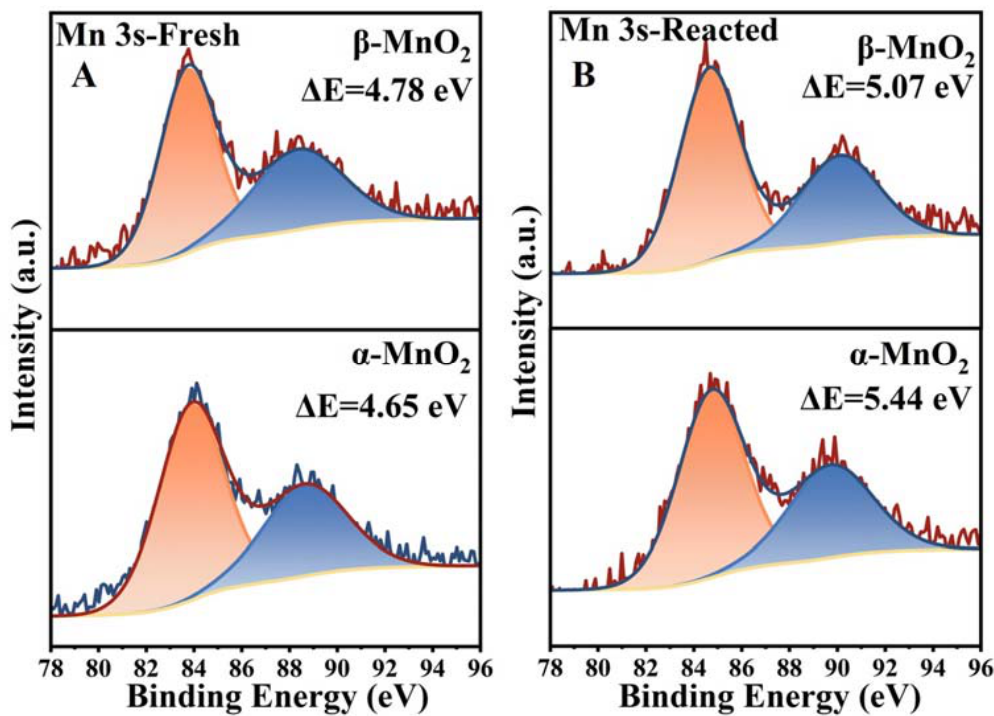
Figure 10. XPS profiles of Mn 3s over the fresh ( A ) and spent ( B ) catalysts. Additionally, Mn 2+ -O and Mn 3+ -O bonds are weaker than Mn 4+ -O [48]. Thus, the higher ratio of low valence Mn (Mn 2+ + Mn 3+ ) endows MnO 2 with a larger proportion of weaker M-O bonds on its surface, meaning the easier release of O to participate in the reaction. Figure 9A showed that α -MnO 2 had more low valence Mn (Mn 2+ + Mn 3+ ) than β -MnO 2 , which also implies the easier release of surface oxygen species, consistent with the results of H 2 -TPR and O 2 -TPD. Comparison of the Mn 2p 3/2 spectra before and after the reaction (Figure 9B) of MnO 2 with CH 3 SH showed that the valence state of Mn in both samples changed obviously, suggesting the electron transfer during the reaction. For both samples, Mn 4+ decreased, and Mn 2+ and Mn 3+ increased, proving that the high-valent Mn (IV) was reduced by gaining electrons during the reaction. After the reaction, the Mn 2+ +Mn 3+ /Mn 4+ of α -MnO 2 increased by 1.51 and that of β -MnO 2 by 1.39, and AOS decreased by 0.74 for α -MnO 2 and that of β -MnO 2 decreased by 0.5 (Figure 10B), testifying that α -MnO 2 was reduced to a greater extent by gaining more electrons than β -MnO 2 , which can well match H 2 -TPR results. It is noteworthy that higher AOS usually indicates a stronger electron-gaining ability of the catalyst because of the presence of more high-valent atoms, however, α -MnO 2 exhibited a stronger electron-gaining ability in the reaction with CH 3 SH, suggesting that oxygen vacancies play a more important role in catalyzing CH 3